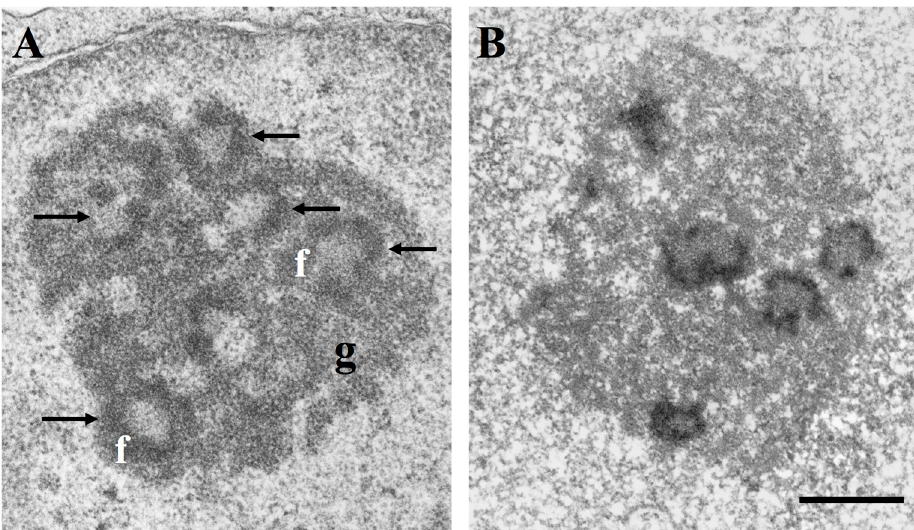
Figure 1. Nucleolar ultrastructure and location of the silver-stained Nucleolar Organizer Region (NOR) proteins in the fibrillar components; ( A ) electron microscope visualization of a nucleolus of a TG cell (established cell line from a human fallopian tube cancer) after uranium and lead staining. Arrows indicate fibrillar centres with the peripheral rim of dense fibrillar component (f). The granular component (g) surrounds the fibrillar components. Bar = 0.5 µ m; ( B ) Electron microscope visualization of a TG cell nucleolus after specific silver staining for NOR proteins. Only the fibrillar centres and the associated dense fibrillar component are stained by silver. Bar = 0.5 µm.